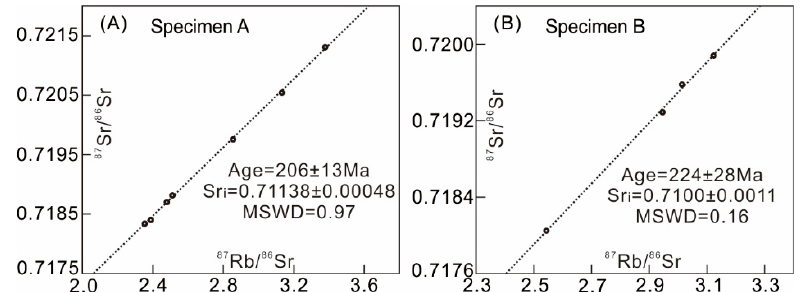
Figure 6. ( A , B ): Rubidium-Strontium isochrons of pyrite separates from carbonate rock specimens A and B, respectively, located at ~4952 m in the YD-2 well. (Sr i represents the initial 87 Sr/ 86 Sr ratio. MSWD is the mean square of weighted deviates.) Table 1. Rubidium-Strontium isotope data for pyrite sub-samples from specimens A and B in this study.